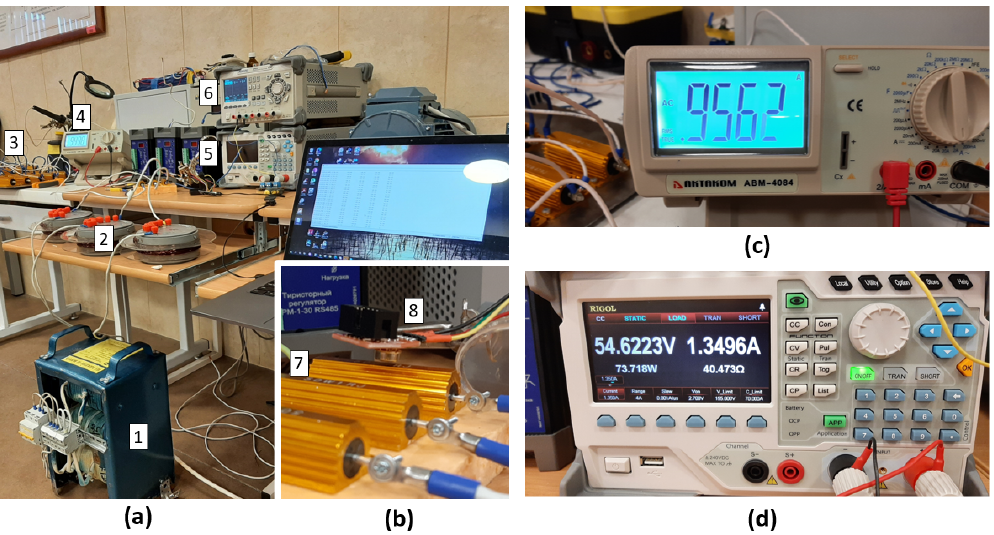
Figure 8. Photos of laboratory bench: ( a ) general view; ( b ) line resistors and infrared temperature sensor; ( c ) ammeter for AC current measurement; ( d ) DC electrical load unit, where 1—transformer,